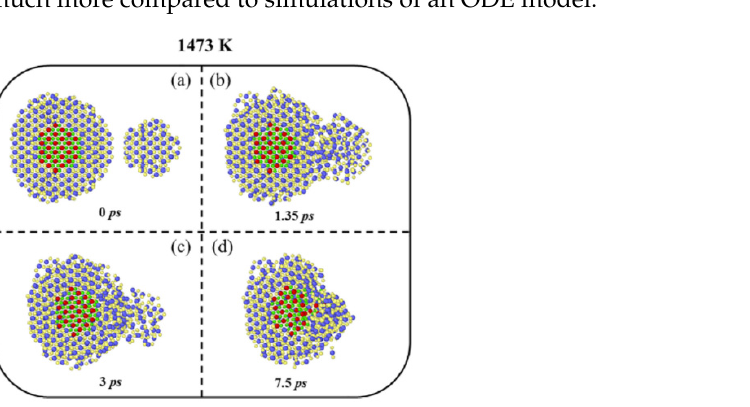
Figure 13. Snapshots from the results of molecular dynamics simulations of the sintering process for TiO 2 nanoparticles. Reprinted with permission from Ref. [159]. Copyright 2022, Elsevier.